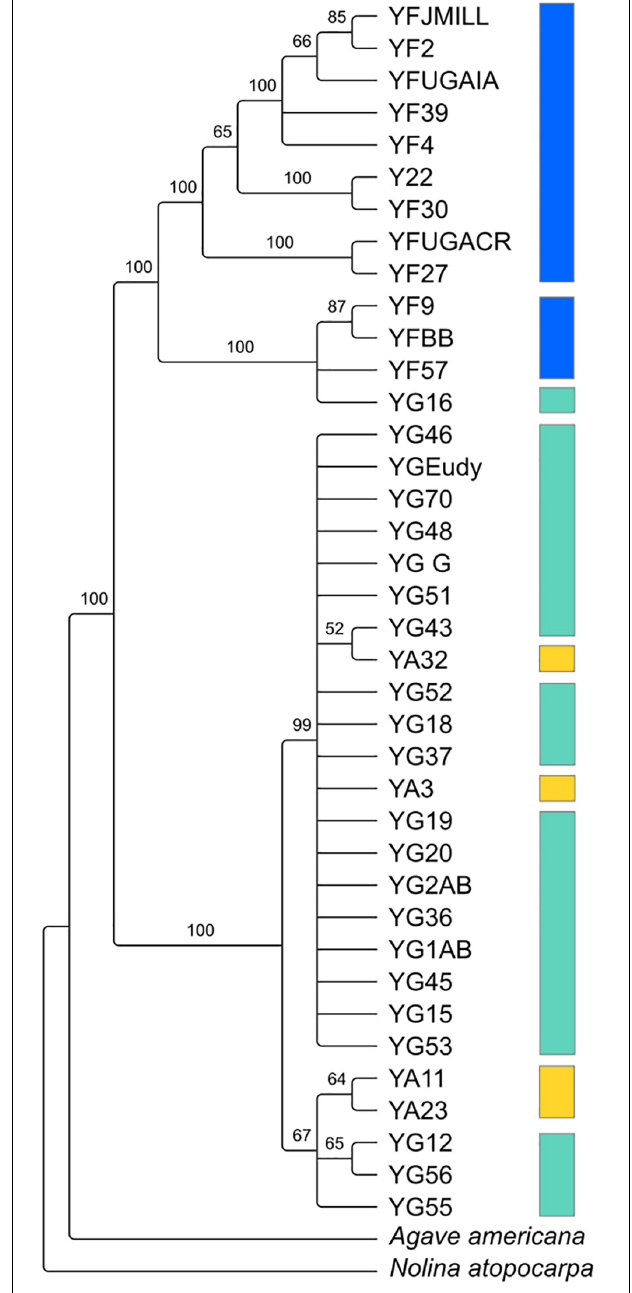
FIGURE 2 | RAxML estimated phylogeny of the plastome using only one inverted repeat copy in the alignment. Bootstrap support indicated on the branches, with nodes that had less than 50 bootstrap support collapsed. Colors indicate the three species: Y. aloifolia (yellow), Y. filamentosa (blue), and Y. gloriosa